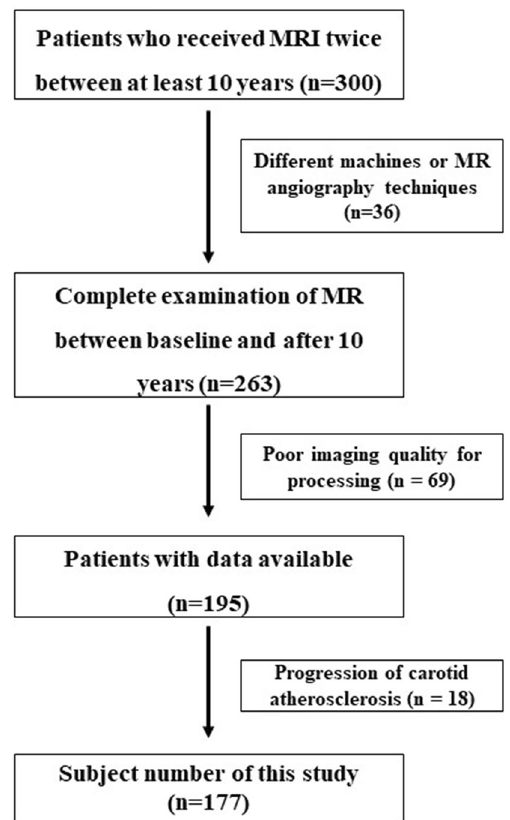
Figure 2. Subject selection.